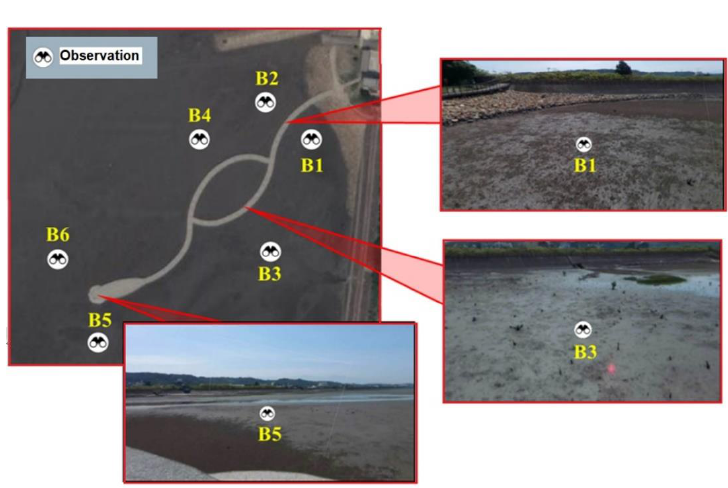
Figure 4. Hsiang Shan wetland and its observation points. Table 3. Hsiang Shan wetland area and its creatures’ characteristics and food sources. Wetland Creatures Characteristics and Food Sources B1. Fiddler Crab